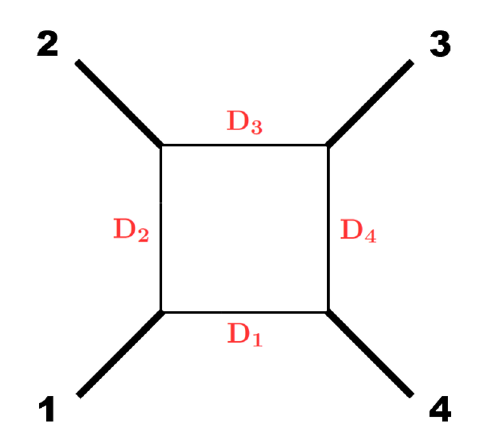
Figure 1. 1-loop diagram with 4 external massive